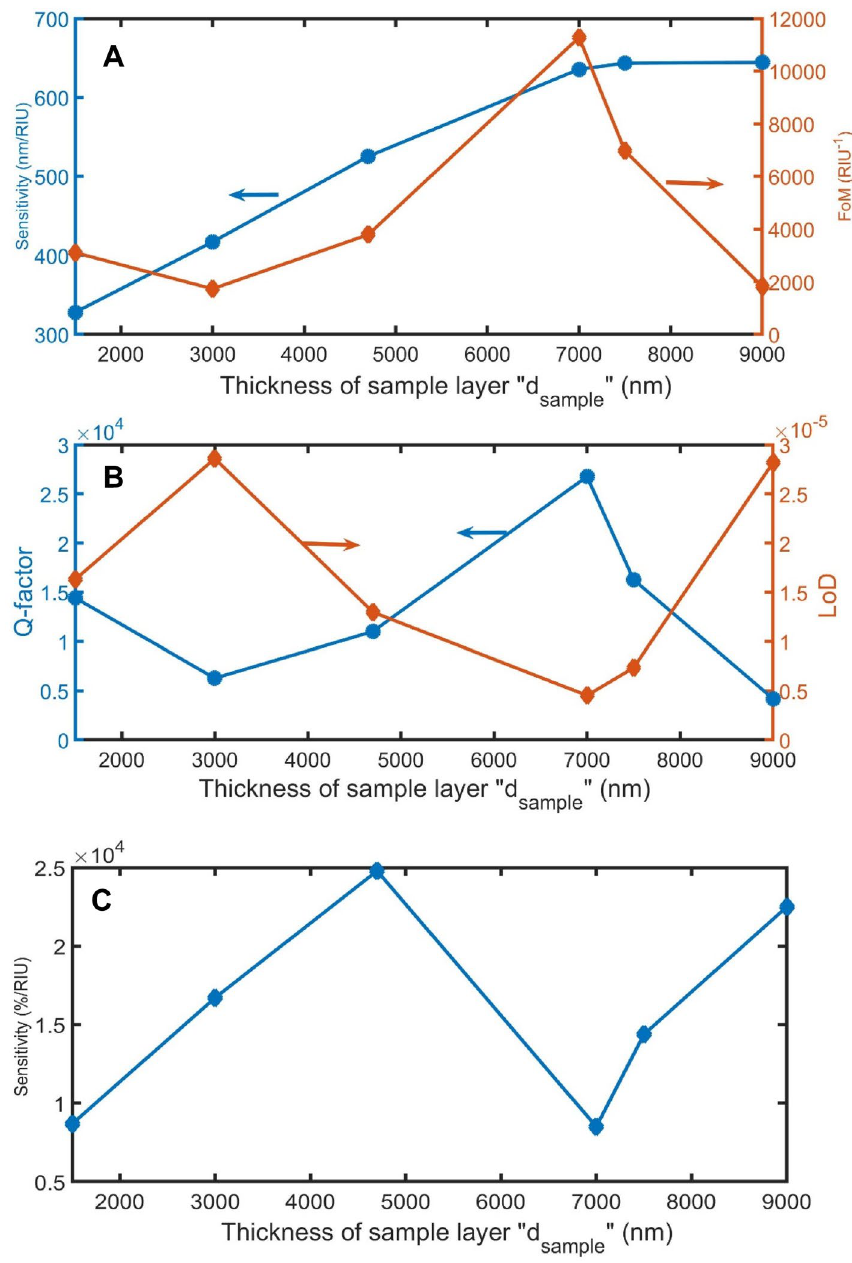
Figure 4. The impact of d sample on ( A ) sensitivity in nm/RIU and FoM, ( B ) Q and LoD, and ( C ) sensitivity in %/ LoD becomes less valuable at this thickness. Although the thickness of 7000 nm has the lowest sensitivity in %/ RIU, the thickness of 7000 nm will be favorable because of the above advantages. As shown in Fig. 5A–C, when the macroscopic Lorentz oscillation intensity of both loss and gain layers increases from 2.3 × 10 –4 to 2.9 × 10 –4 , the sensitivity in nm/RIU unit increase becomes linear and near to zero, FoM gradually increases from 11,277 to 62,364 RIU −1 , Q gradually increases from 26,762 to 148,012, LoD linearly decreases from 5 × 10 –6 to 8 × 10 –7 , and the increase in the sensitivity in %/RIU unit value strongly increases from 25,461 to 1,117,565 %/RIU. The real and imaginary dielectric constant of gain and loss layers are drawn and studied to analyze the impact of macroscopic Lorentz oscillation intensity on the magnification of transmittance. As clear in Fig. 6A,B, by increasing the macroscopic Lorentz oscillation intensity from 2.3 × 10 –4 to 2.9 × 10 –4 , the gap between the real and imaginary part of the dielectric constants of loss and gain layers increases. As a result, the magnification